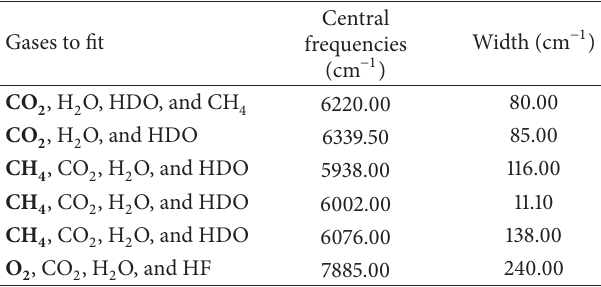
Table 1: Retrieval window parameters for CO 2 , CH 4 , and O 2